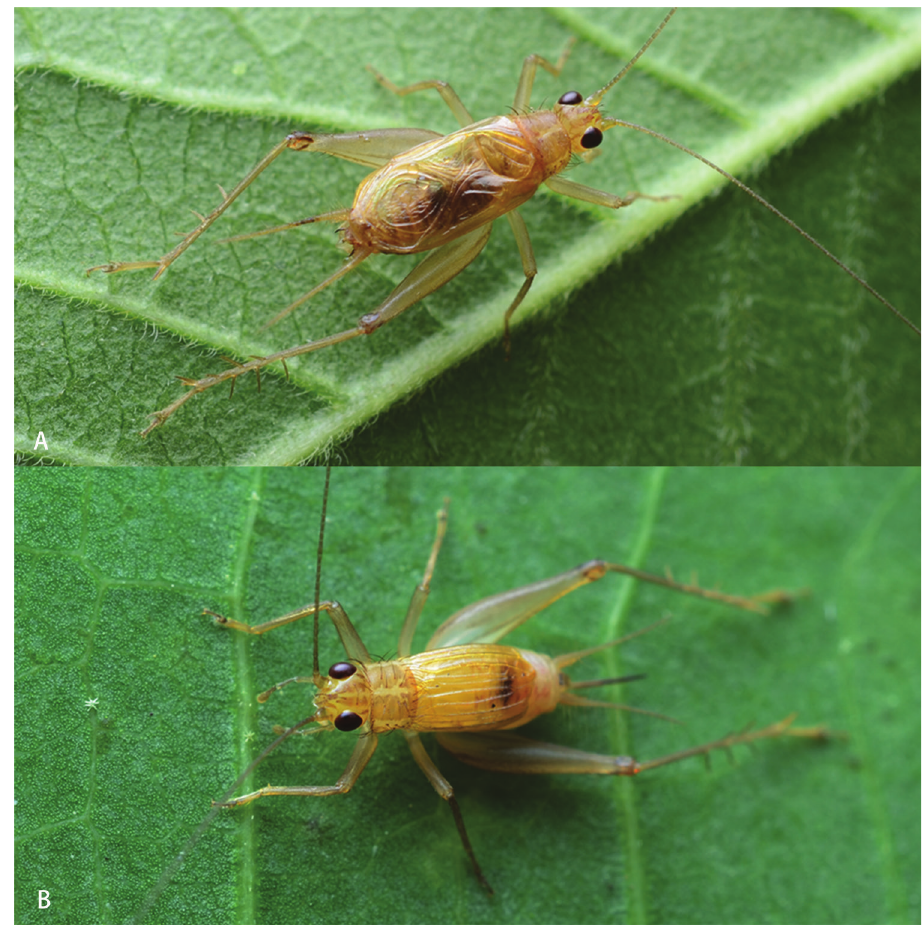
Figure 2. Habitus (alive) of A. nonggangensis sp. nov. on leaf A male B female (photography: Zhang, Tao).